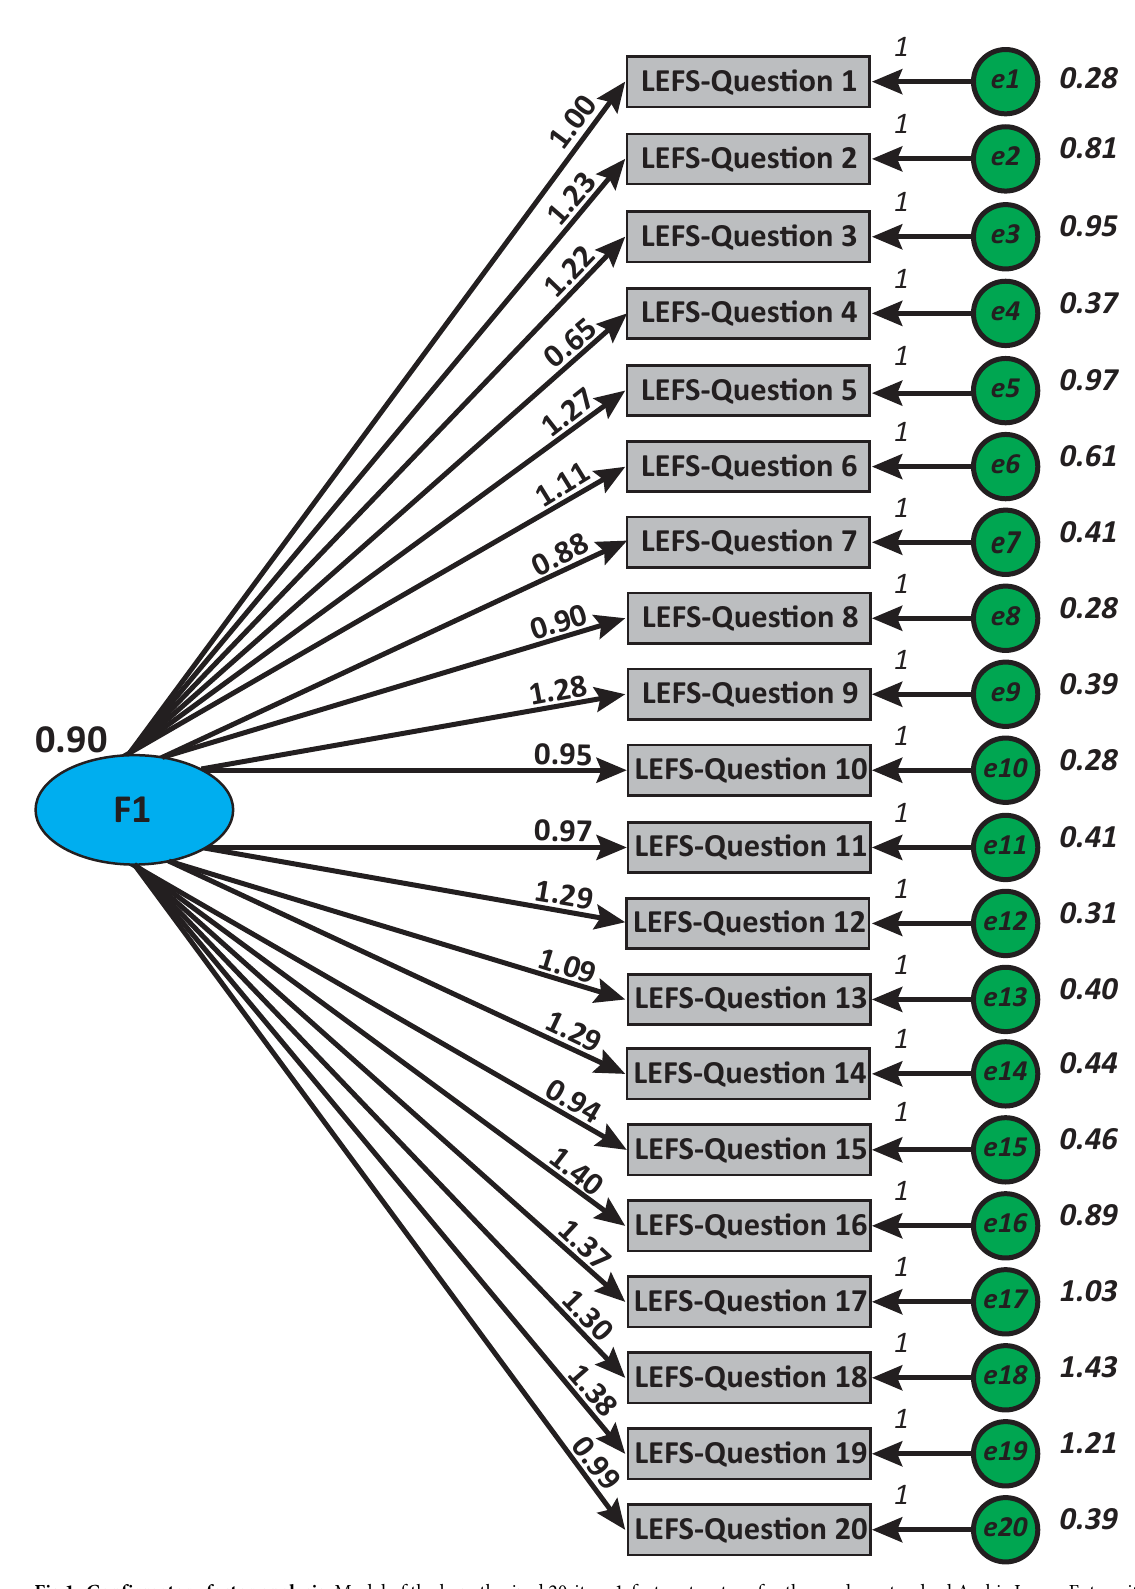
Fig 1. Confirmatory factor analysis. Model of the hypothesized 20-item 1-factor structure for the modern standard Arabic Lower Extremity Functional Scale (LEFS-MSAr). https://doi.org/10.1371/journal.pone.0217791.g001 PLOS ONE | https://doi.org/10.1371/journal.pone.0217791 June 10,